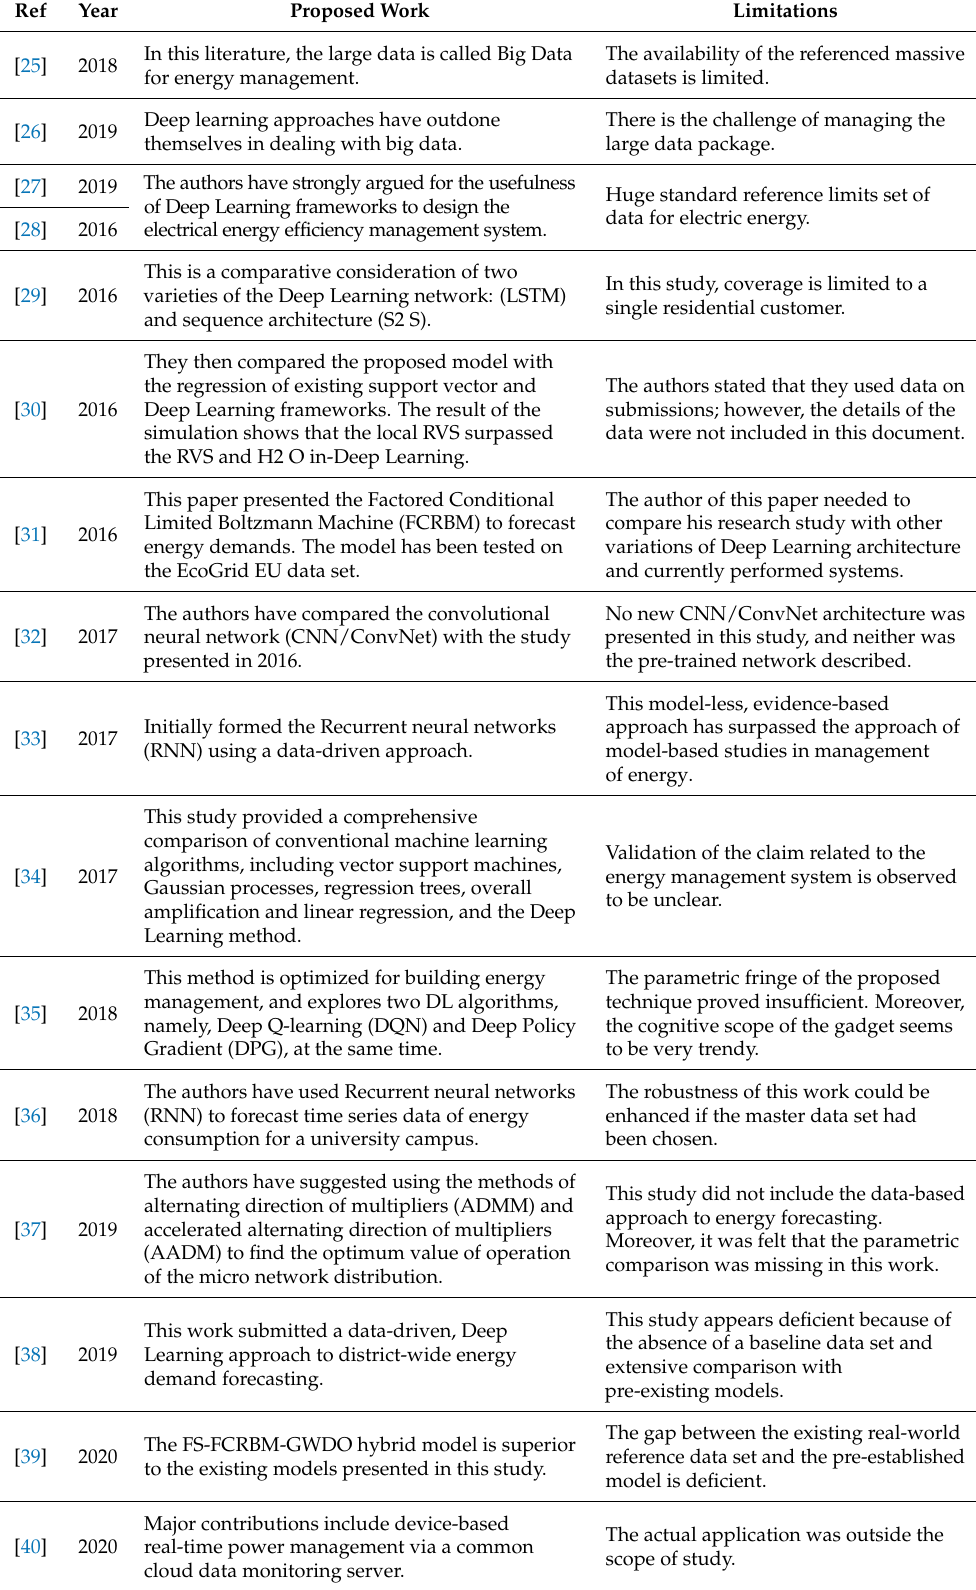
Table 1. Literature map on energy management using artificial